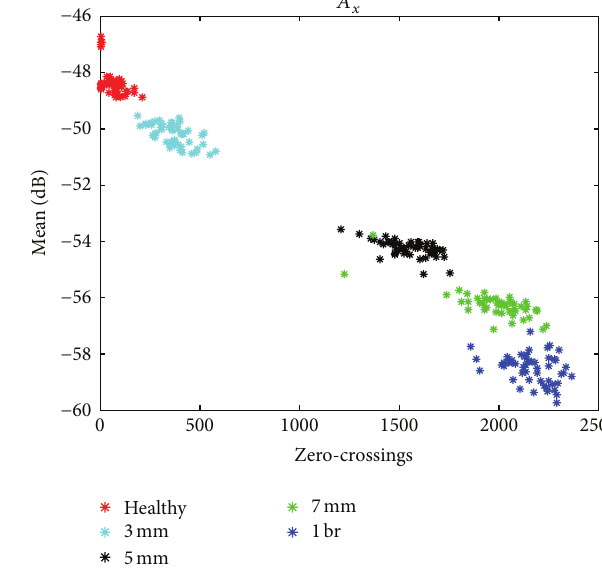
Figure 9: Unload condition analysis, 𝐴 𝑥